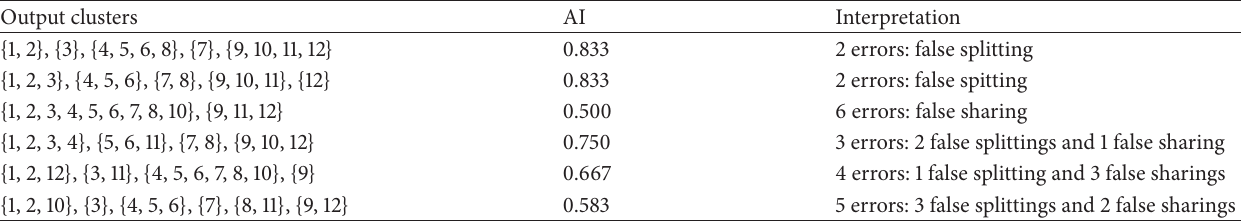
Figure 10: Accuracy index for every 3 seconds and for every 1.5 seconds. Table 4: Results of FlowMate and our SVD based approach with three correct clusters ( { 1, 2, 3 } , { 4, 5, 6, 7, 8 } , and { 9, 10, 11, 12 } ). Our SVD based approach always reported the accurate clusters whereas false sharing and wrong splitting were observed in FlowMate results.